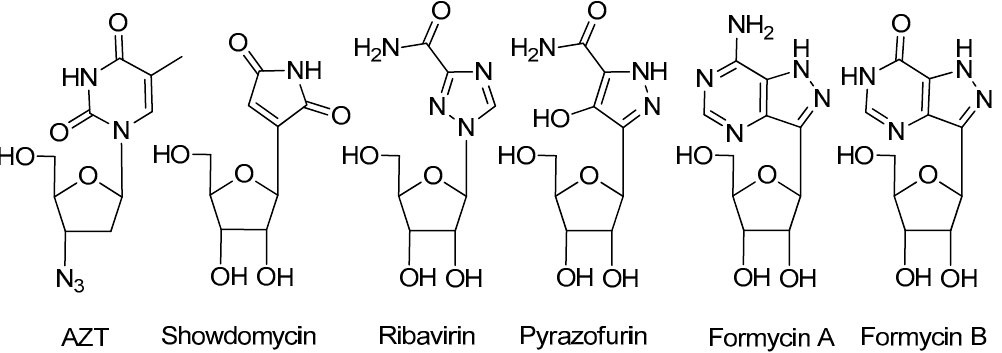
Figure 1. Selected nucleoside analogues with antiviral and / or antitumoral activities: 3’-azidothymidine (AZT or ZDV), showdomycin, ribavirin, pyrazofurin, formycin A and formycin B.